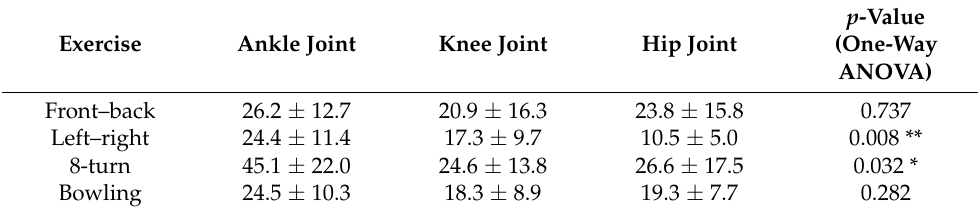
Table 3. Range of motion (unit: deg) of each joint during LOCOBOT